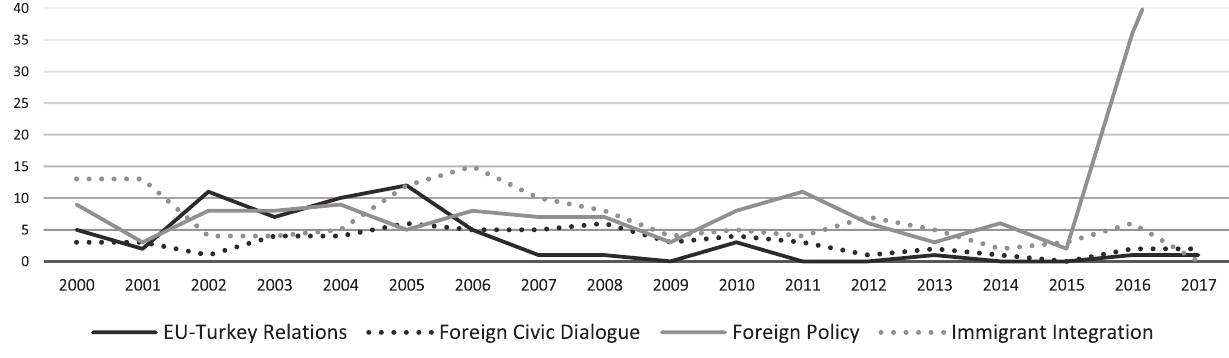
Figure 5. The Turkish issue in the German media discourse (own data